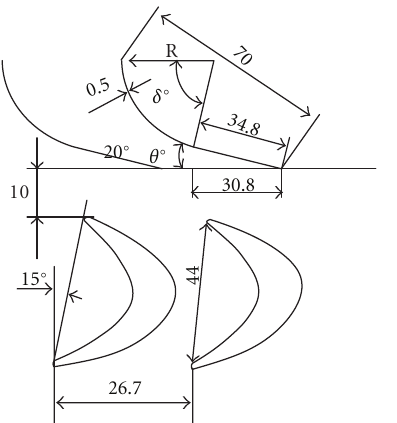
Figure 19: Configuration of a unidirectional impulse turbine.